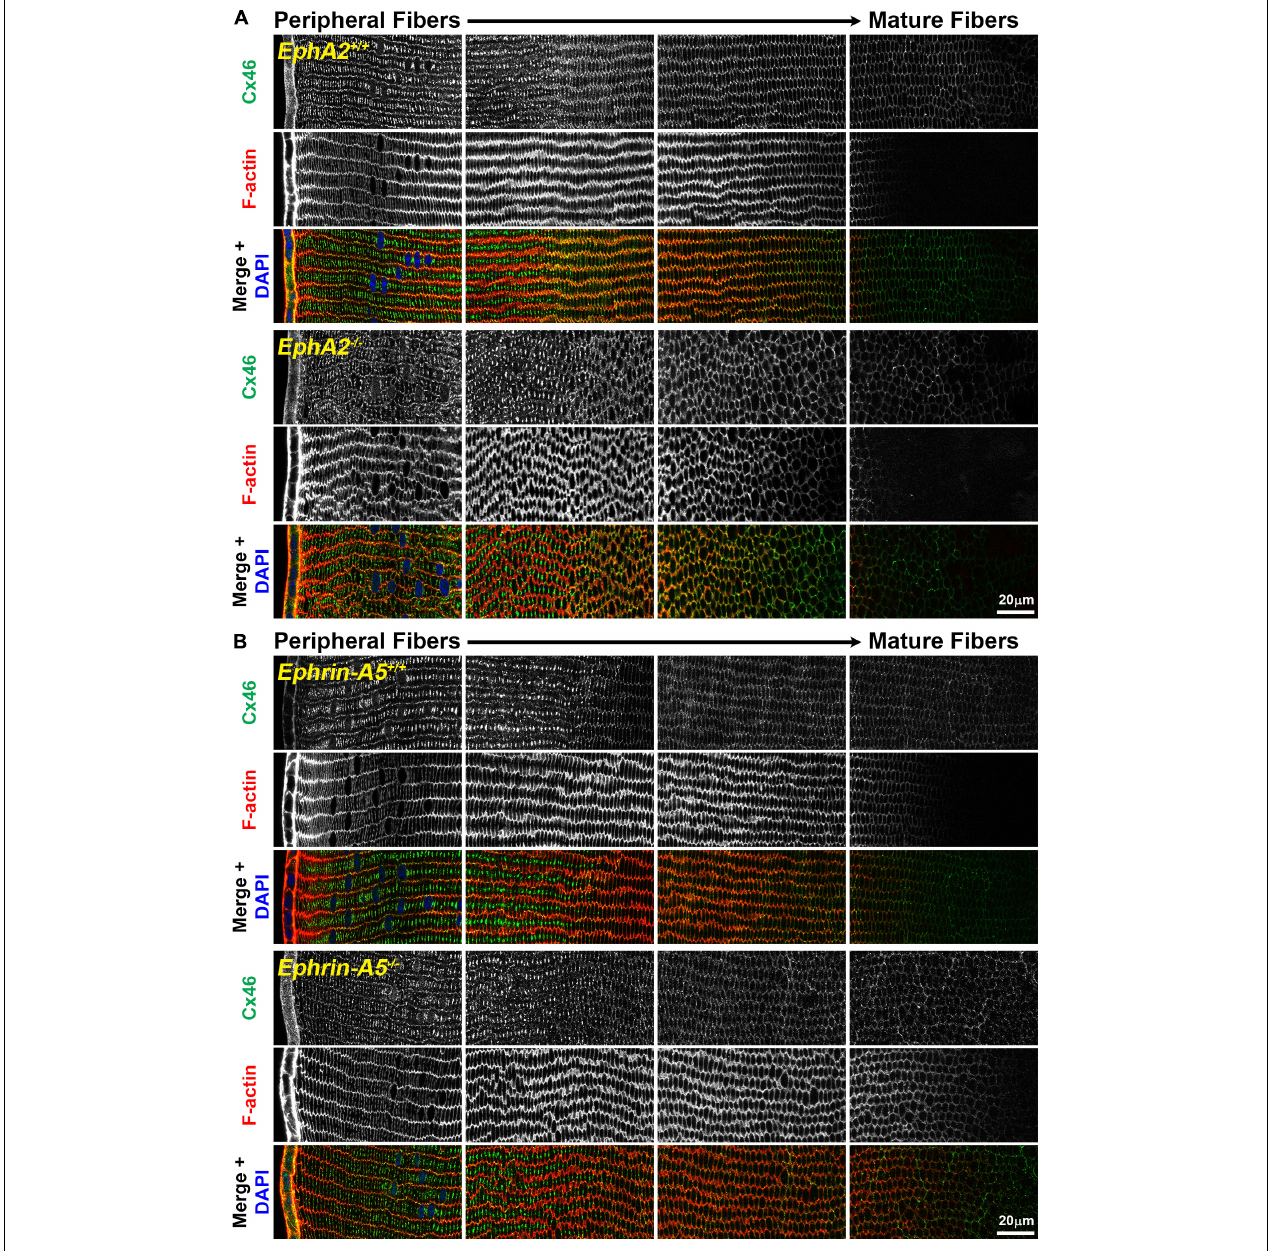
FIGURE 1 | Connexin 46 (Cx46, green) and phalloidin (F-actin, red) staining in cross sections from control, EphA2 − / − and ephrin-A5 − / − lenses. Images are from the periphery to the inner mature fiber cells of the lens. (A) Cx46 is present at the cell membrane and is enriched on the long sides of peripheral differentiating fiber cells and becomes uniformly distributed around the cell membrane during maturation. The staining pattern is similar between control and EphA2 − / − lens fibers, despite the disorganization of EphA2 − / − cells. (B) Cx46 displays a similar localization pattern in peripheral and mature control and ephrin-A5 − / − lens fibers. Scale bars, 20 µ